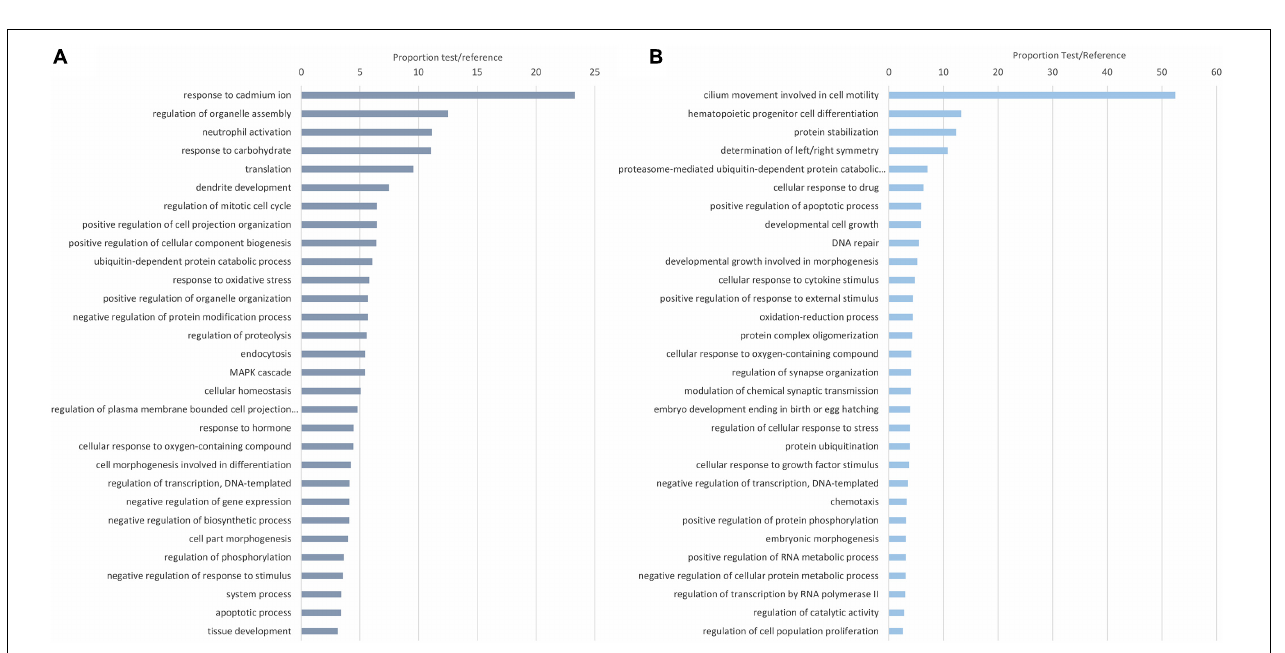
FIGURE 3 | Enrichment analysis showing the top 30 enriched biological processes in the upregulated (A) and downregulated (B) differentially expressed proteins (DEPs). The 30 most overrepresented biological processes (Fisher’s exact test, FDR < 0.05) were represented for both the upregulated (A) and downregulated (B) DEPs. Biological processes are represented in accordance with their test/reference proportion (test = presence of a particular process in the studied DEPs; reference = presence of a particular process in the whole proteome).